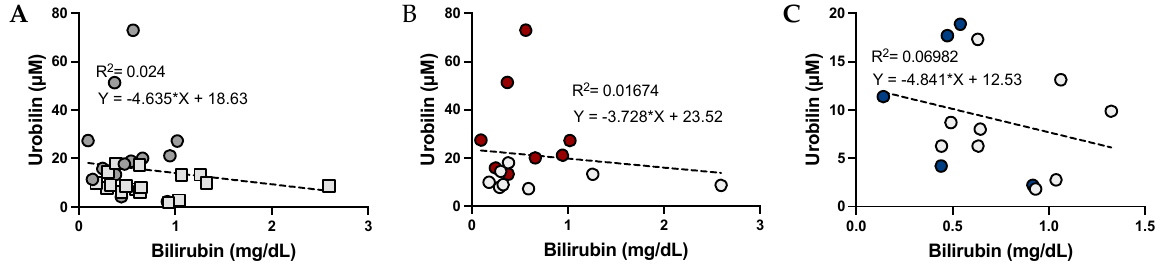
Figure 1. The relationship between urobilin and total bilirubin levels in women and men. Pear- son’s coefficient comparisons in all samples from men and women to determine the slope of the line and the relationship between urobilin and bilirubin in lean participants of both sexes ( A ), only women ( B ) or only men ( C ). The data were plotted as dot plots, linear regression was calculated, and the slope of the line was used to determine the relationship and the robustness of the data. Light gray squares are for lean women and men combined, and dark gray circles are for obese men and women combined. Red circles are for obese women, blue circles are for obese men, and gray circles are for their lean counterparts.